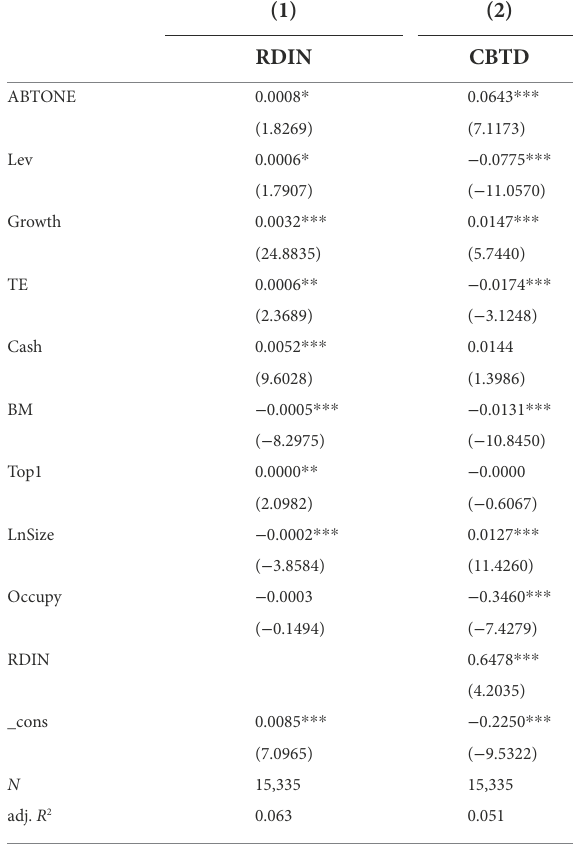
TABLE 5 Impact of managerial irrational expectations on R&D